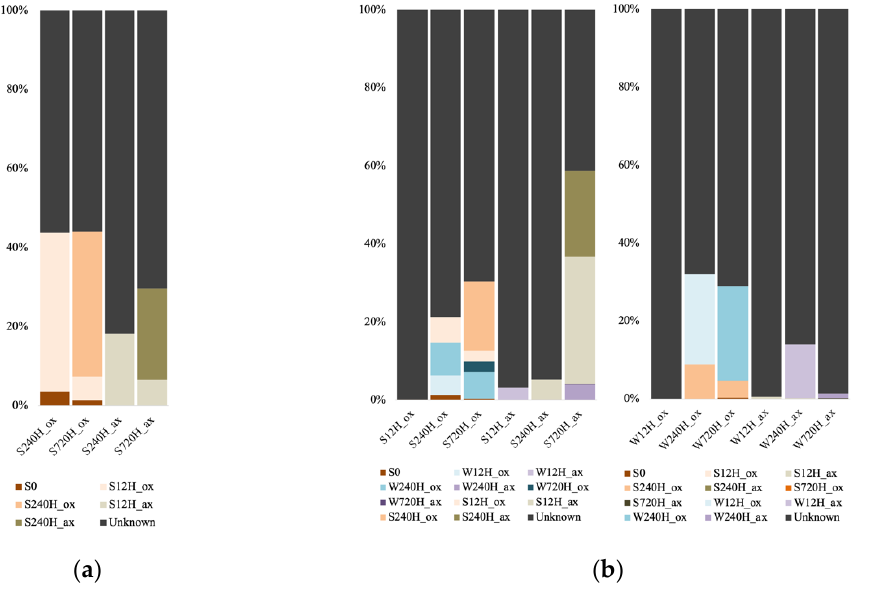
Figure 9. Microbial source tracking of ( a ) archaeal sediment communities using the initial sediment (S0) and the previous sediment incubations time points (S) as sources; ( b ) bacterial sediment and leachate communities, using the initial sediment (S0) and the previous sediment (S) and water (W) incubation timepoints as sources.